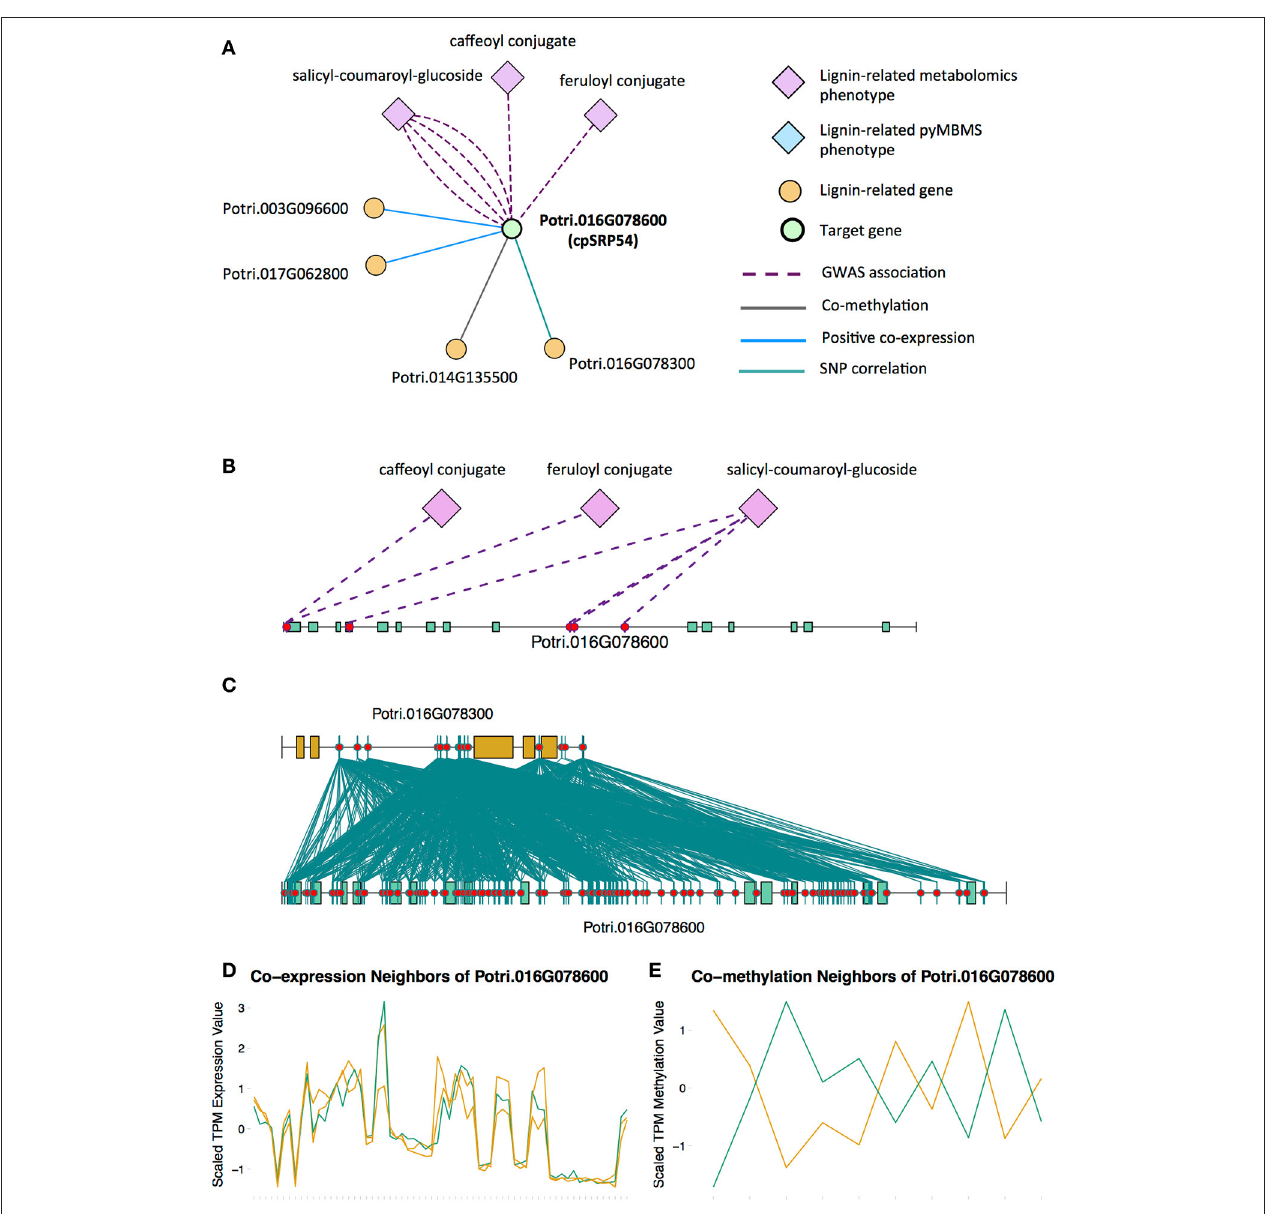
FIGURE 8 | (A) Lines of evidence for Potri.016G078600 (homolog of Arabidopsis cpSRP54). (B) GWAS associations of Potri.016G078600 with three lignin-related metabolite ( Table 1 ). (C) Correlations of SNPs within Potri.016G078600 with SNPs in a lignin-related gene ( Table 4 ). (D) Co-expression of Potri.016G078600 with two lignin-related genes ( Table 2 ). (E) Co-methylation of Potri.016G078600 with a lignin-related gene ( Table 4 ). In line plots, the green lines represent potential target Potri.016G078600 and yellow lines represent lignin-related genes.